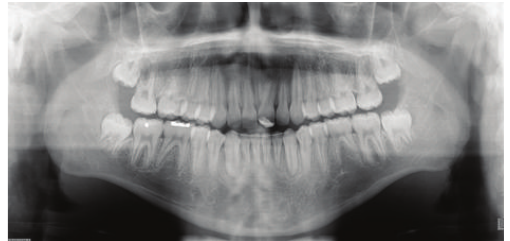
Figure 11: Stage 1: Orthodontic Treatment Final Panoramic Radio- graph.